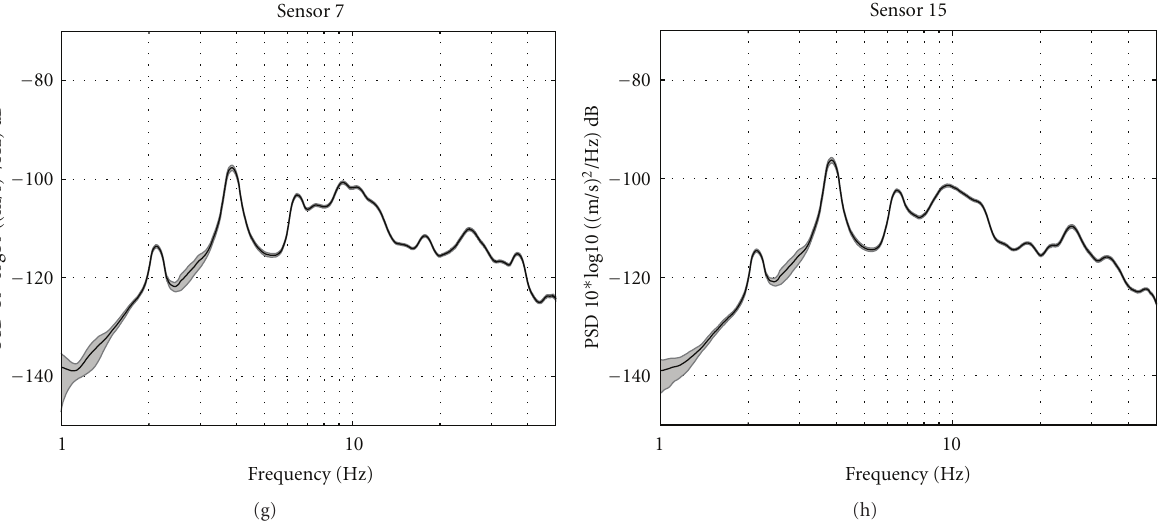
Figure 5: Same as Figures 3 and 4, but for the longitudinal component.